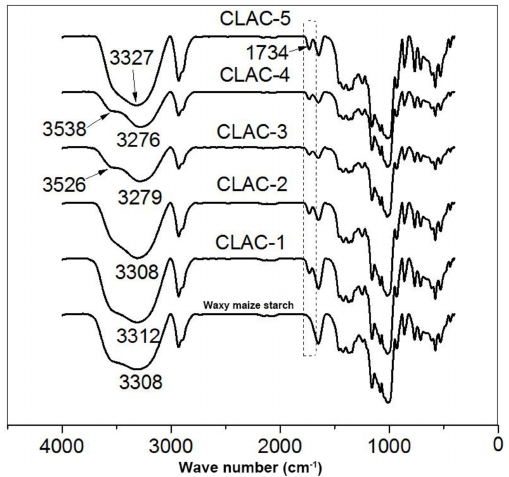
Figure 2. Infrared spectrum of the cross − linked esterified starch